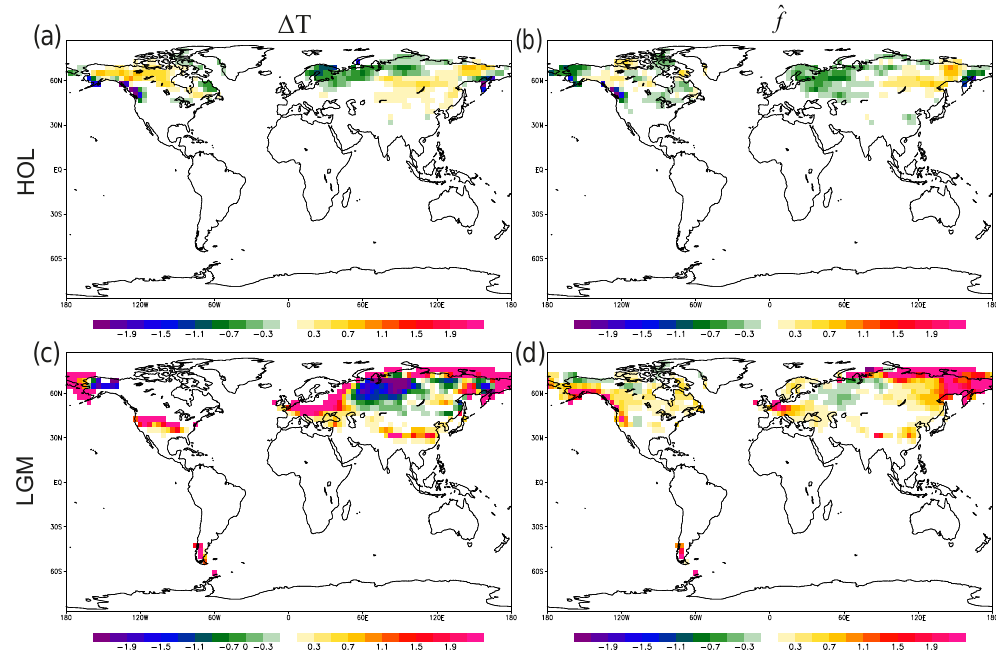
Figure 10. As Fig. 4 but for snow depth (water equivalent in